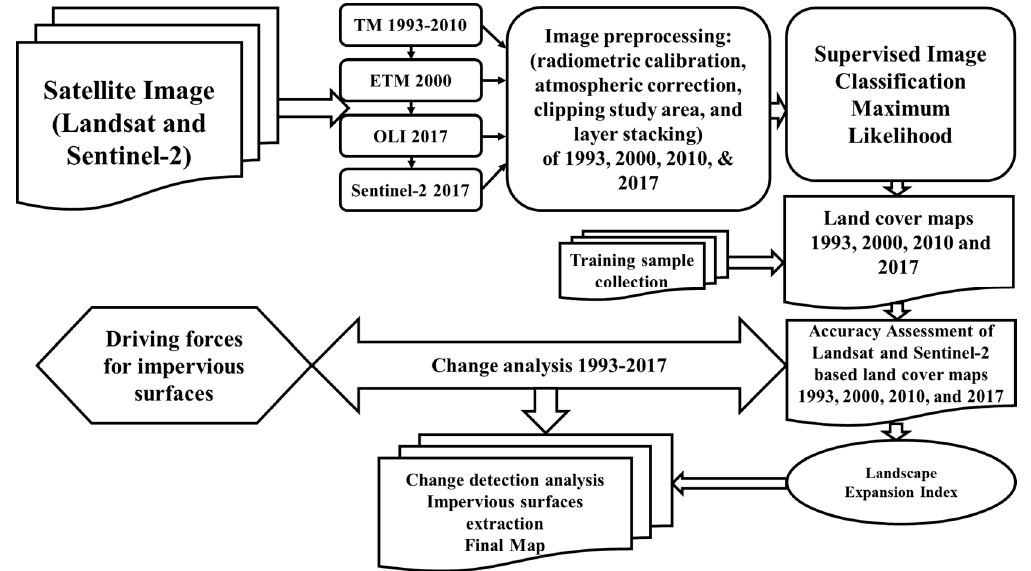
Figure 2. Flowchart of urban expansion method.